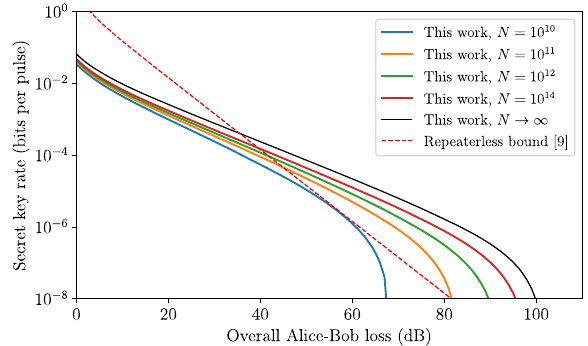
Fig. 2 Secret-key rate obtainable as a function of the channel loss. We consider different values of the block size N , which represents the total number of rounds in the protocol. The overall Alice – Bob loss includes the loss in both quantum channels and in Charlie ’ s detectors. The simulation parameters are stated in the main